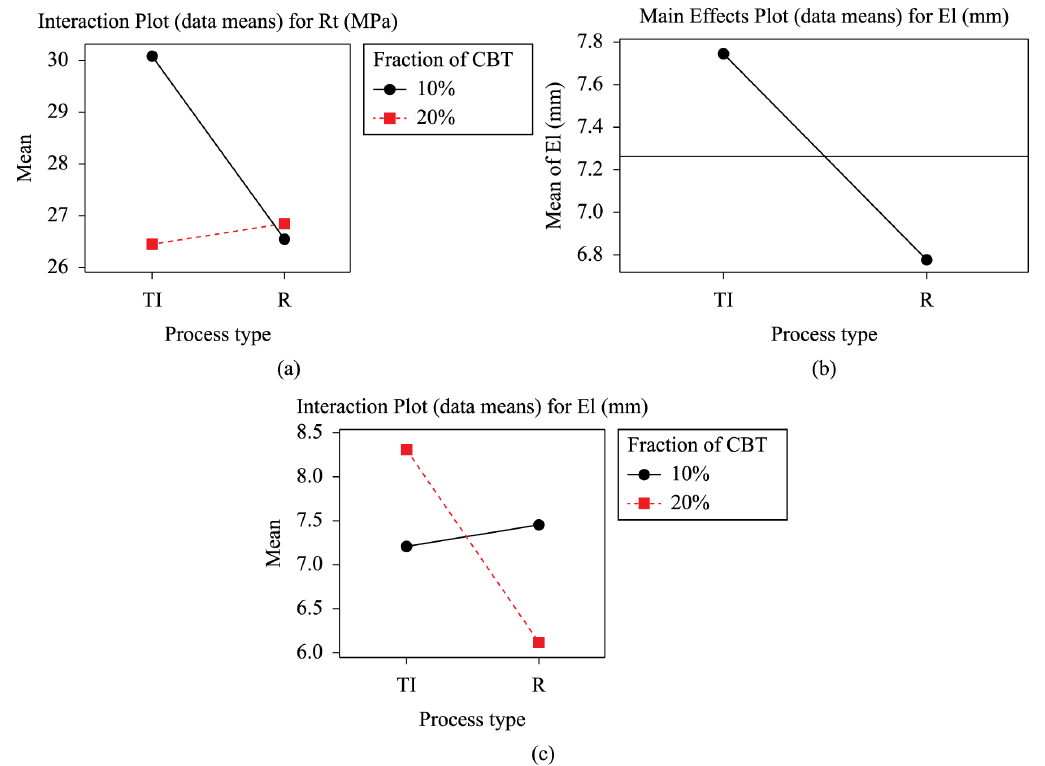
Figure 3. Major factors and their interactions (CBT) for (a) tensile strength and (b, c) maximum tensile strain through